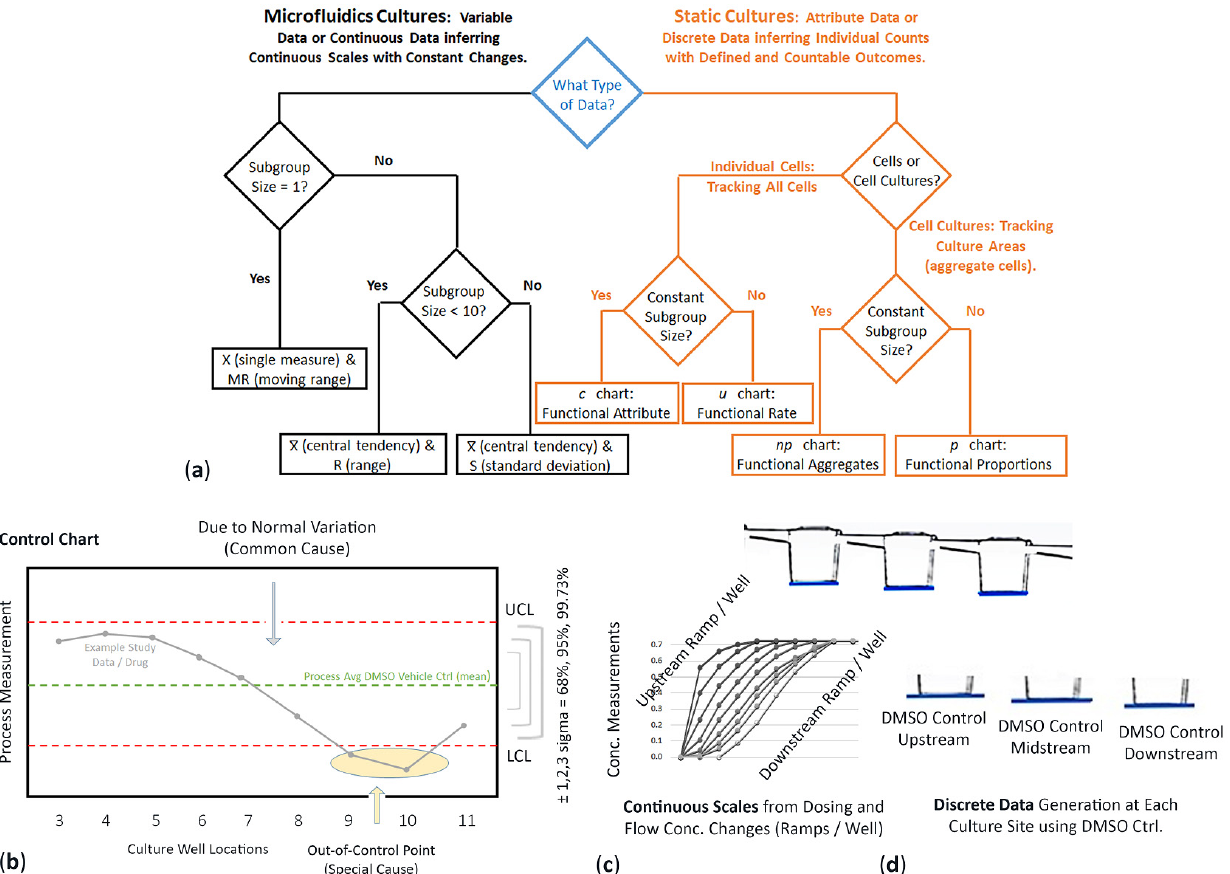
Figure 2. ( a ) Logic tree diagram to select statistical control charts based on data interpretation for microfluidic vs. static cultures. Data types correlate with appropriate statistical analysis. ( b ) X and MR control chart. Variability is described by Nelson rules and tests for special causes or unusual patterns on a production line. ( c ) Continuous exposure scales experienced in upstream wells, midstream wells, and downstream wells. ( d ) DMSO controls are different at each multiwell site along the